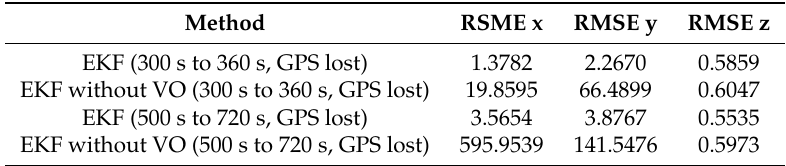
Figure 21. Estimated paths with/without VO update. The GPS outage starts at 500 s. ( a ) Path with VO relative update; ( b ) path without VO relative update. Table 2. Comparisons of path RMSE (m) for GPS